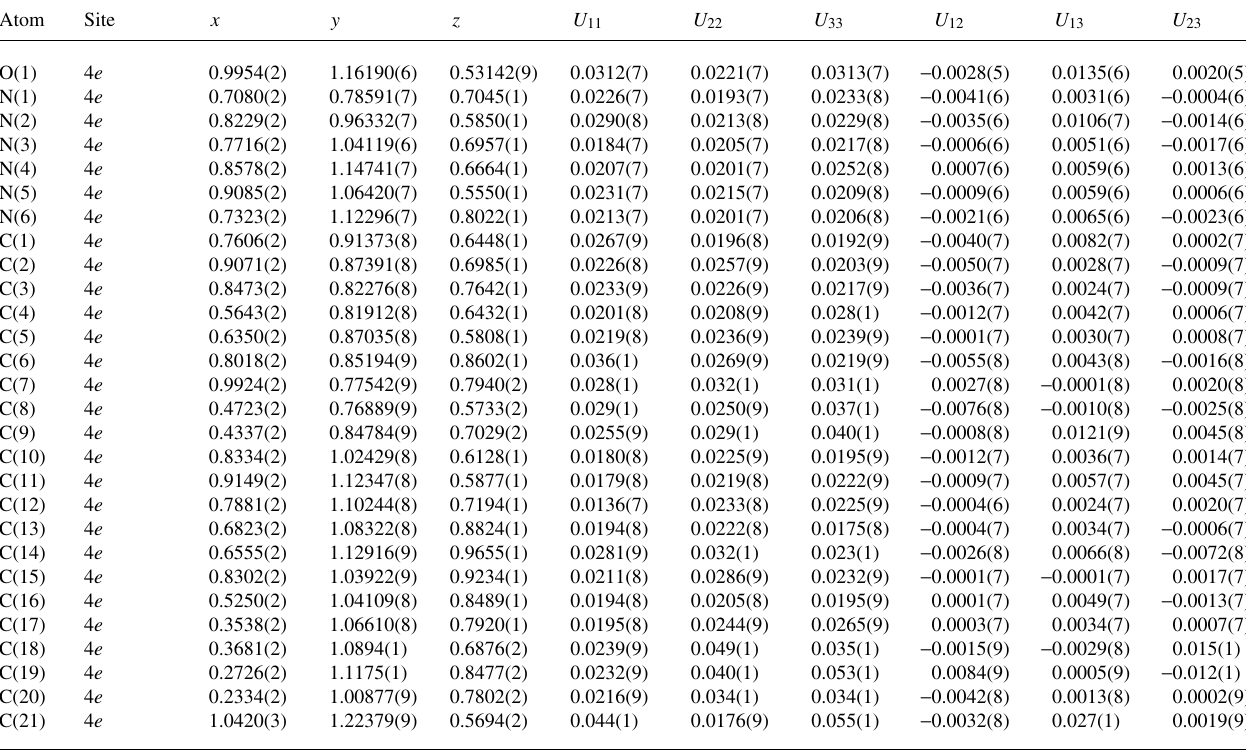
Table 3. Atomic coordinates and displacement parameters (in Å 2 )